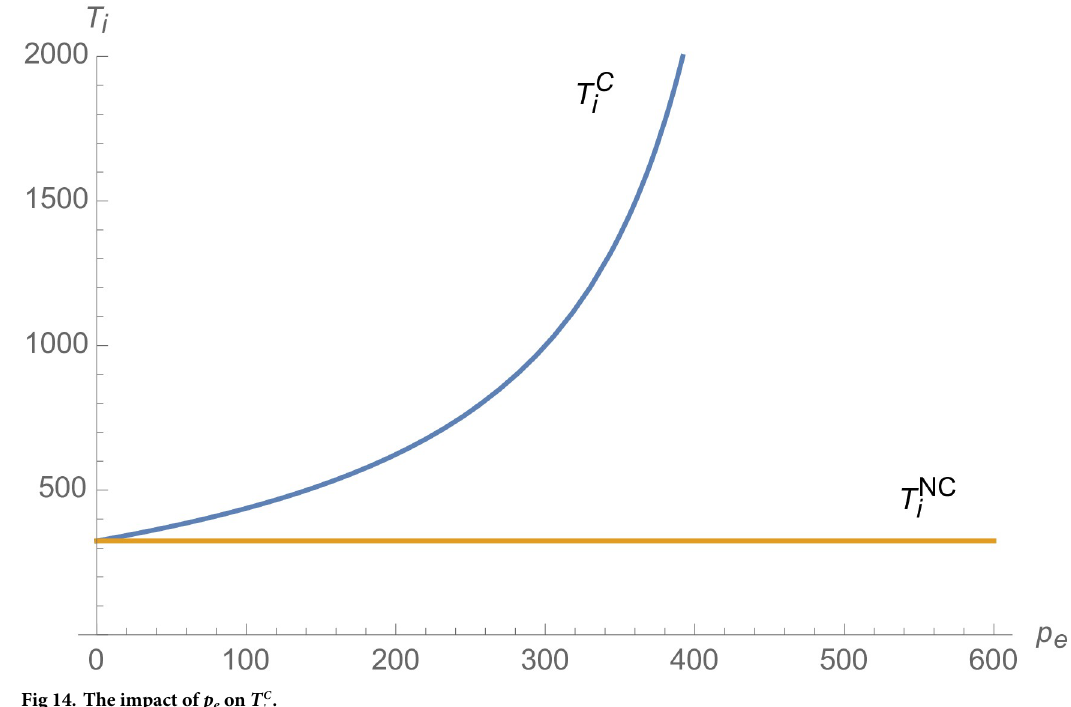
Fig 14. The impact of p e on T C